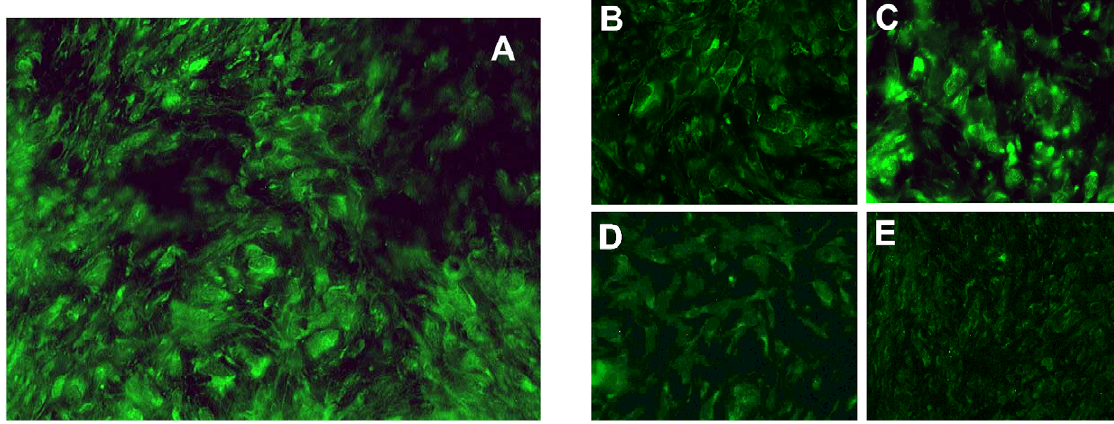
Fig. 7. Frozen sections of solid tumors induced by NIH191-3 at magnifications × 20 (A), and × 40 (B), and by NIH191-10 at magnification × 40 (C), sections stained with core-specific polyclonal rabbit serum 34-6. Area of incapsidation containing suspension of control NIHNS cells stained with anti-core rabbit serum 34-6 at magnification × 40 (D). Solid tumor induced by NIH191-10 stained with the preimmune rabbit serum 34-0 at magnification × 20